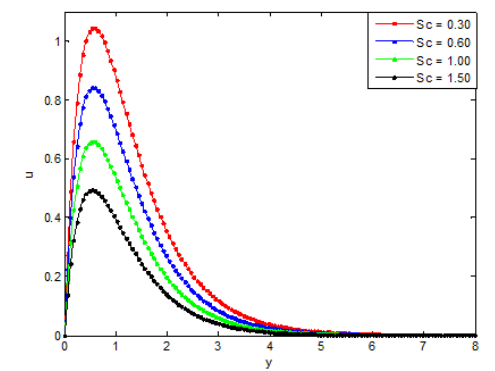
Figure 14. Effects of Schmidt number on the velocity